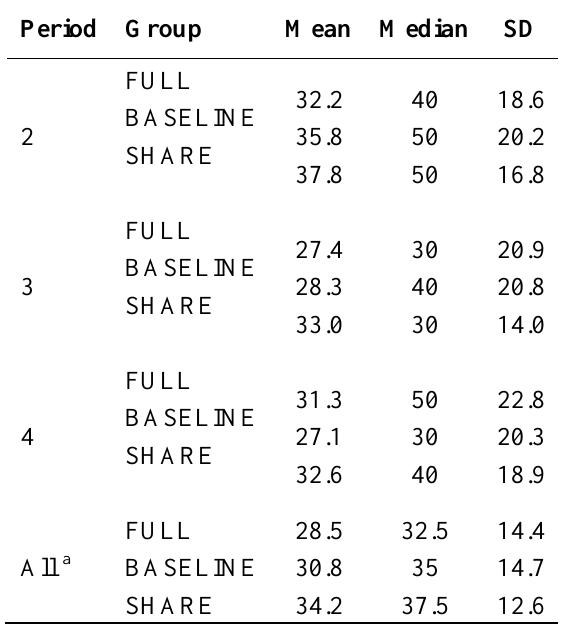
Table 6. Level of co-insurance (%) selected in periods 2–4, by